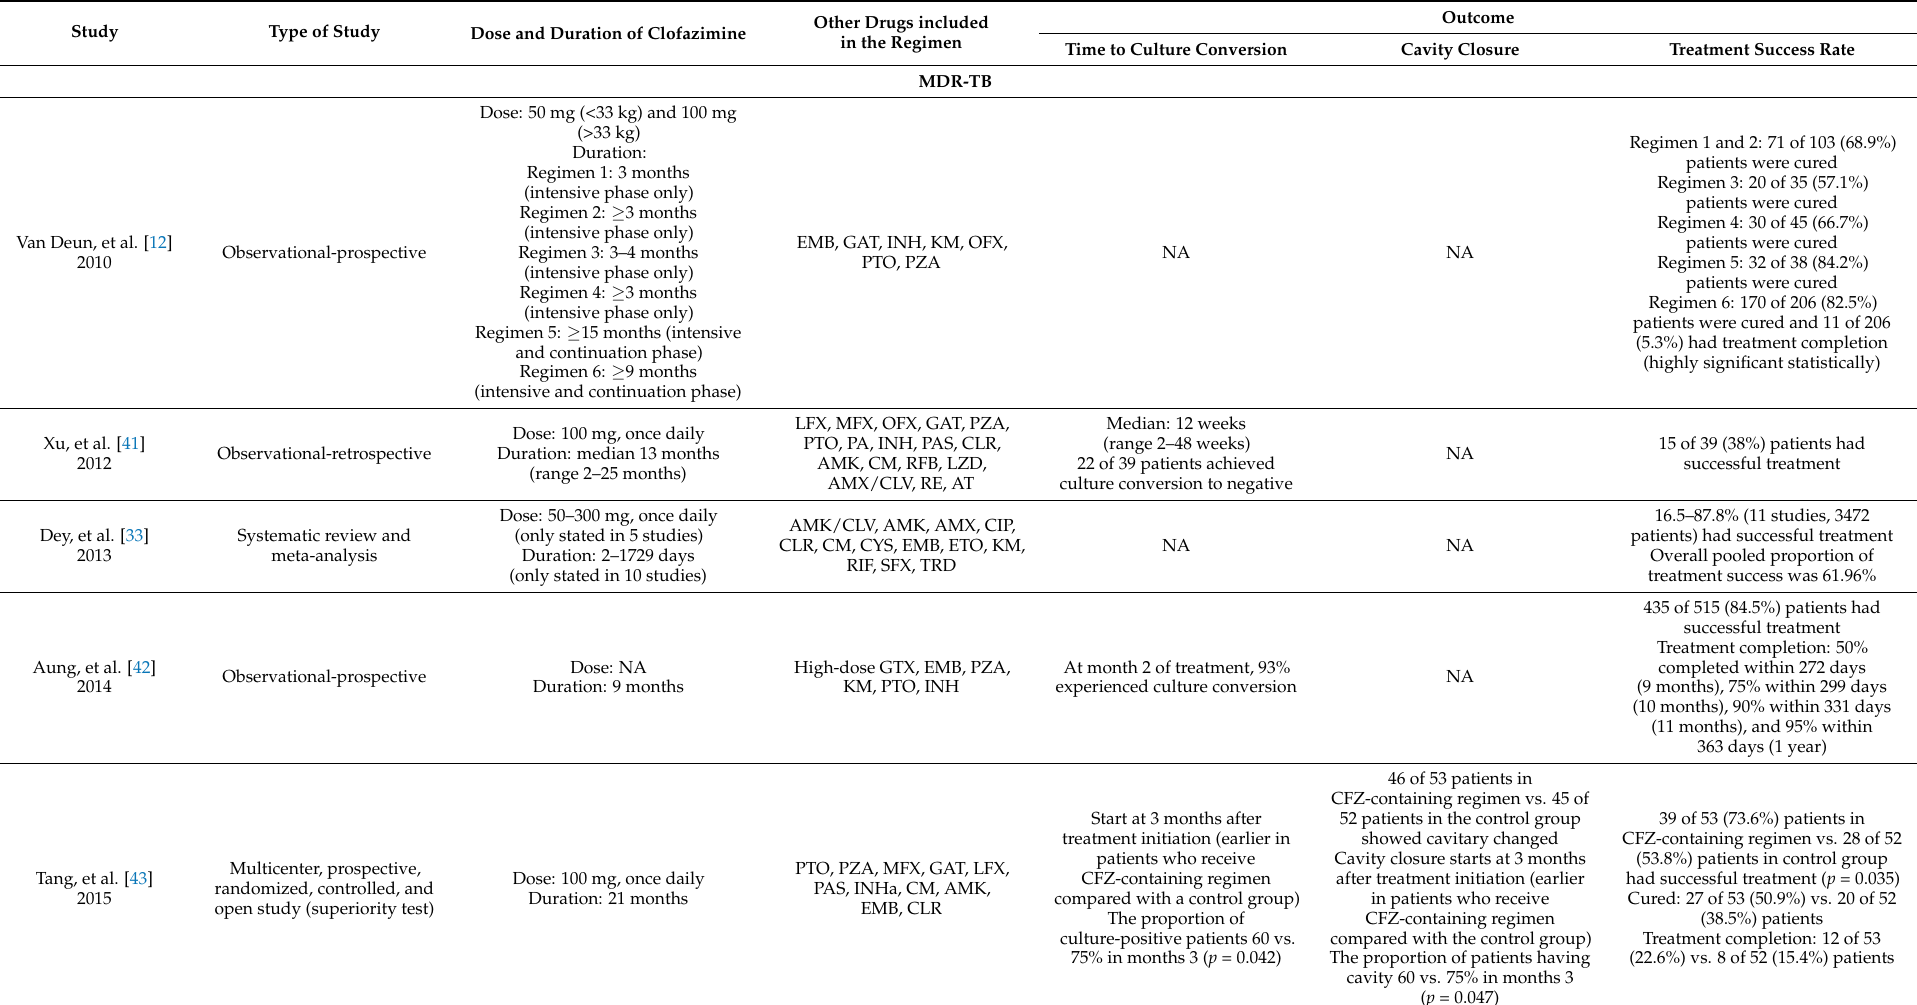
Table 1. Effectivity of Clofazimine for Treating MDR-TB and XDR-TB in Observational and Comparative